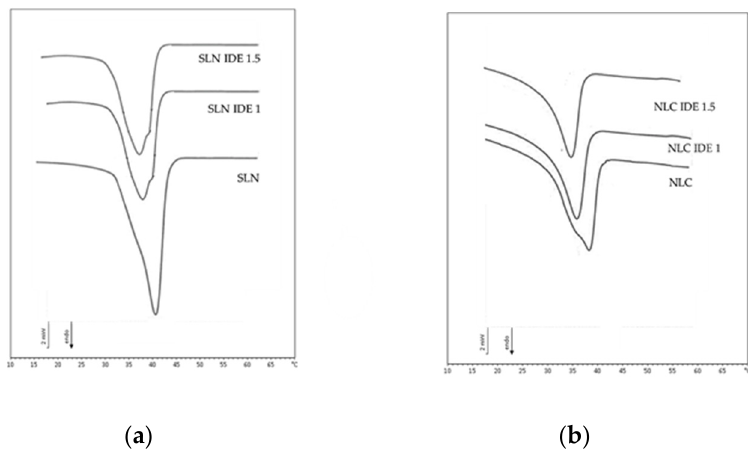
Figure 2. Calorimetric curves, in heating mode, of the following lipid nanocarriers: ( a ) unloaded solid lipid nanoparticles (SLN), SLN loaded with idebenone (IDE) 1% w/w (SLN IDE 1), SLN loaded with idebenone (IDE) 1.5% w/w (SLN IDE 1.5); ( b ) unloaded nanostructured lipid carriers (NLC), nanostructured lipid carriers loaded with IDE 1% w/w (NLC IDE 1), nanostructured lipid carriers